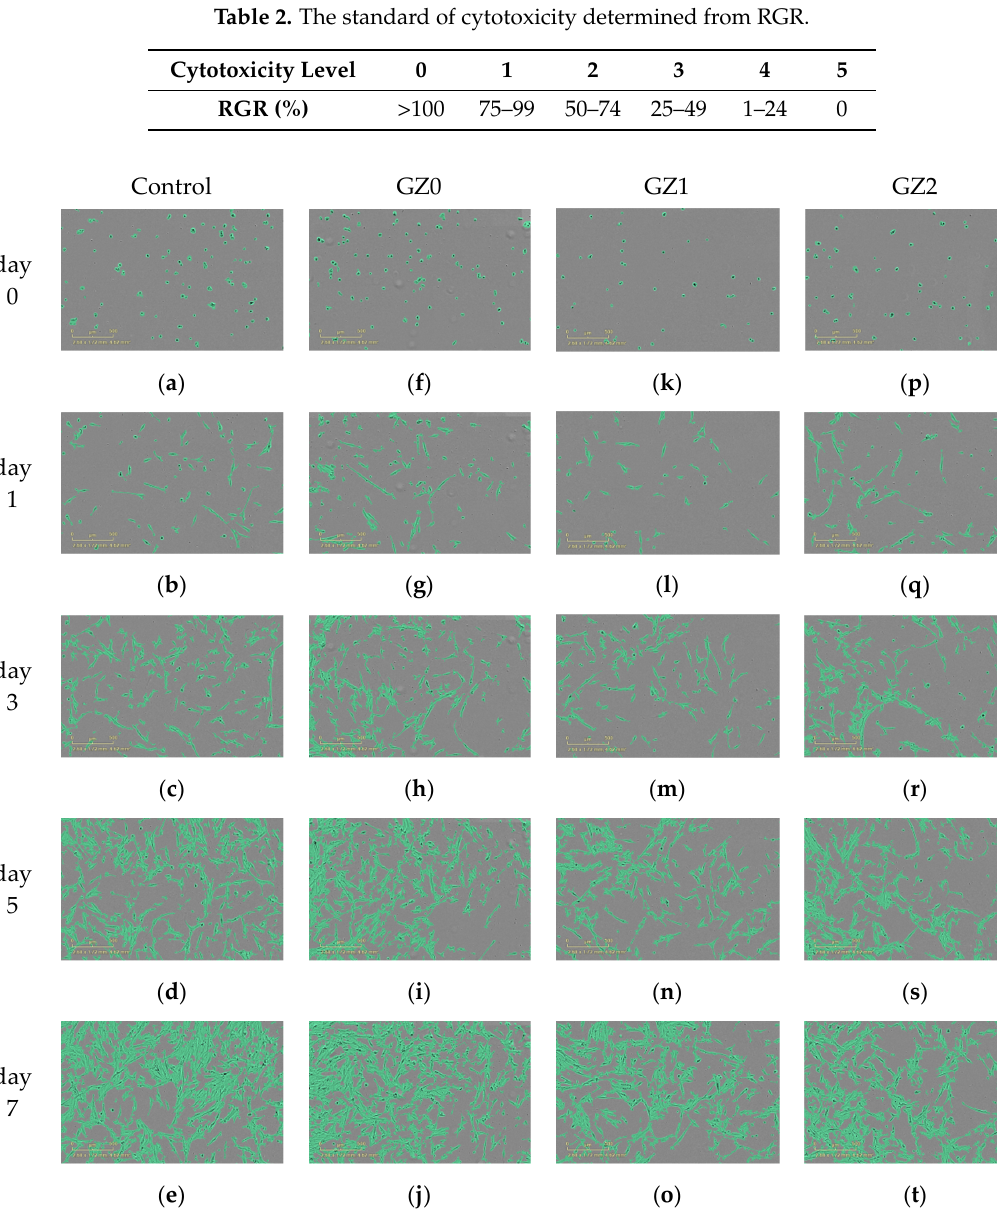
Figure 9. Cell morphology of ( a – e ) Control, ( f – j ) GZ0, ( k – o ) GZ1 and ( p – t ) GZ2 at point of day 0, 1, 3, 5 and 7, respectively. Scale bar: 500 μm.